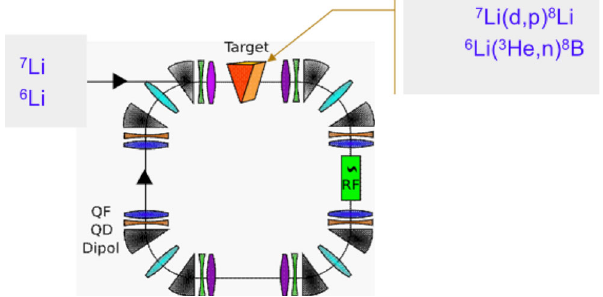
FIG. 8. The production ring.